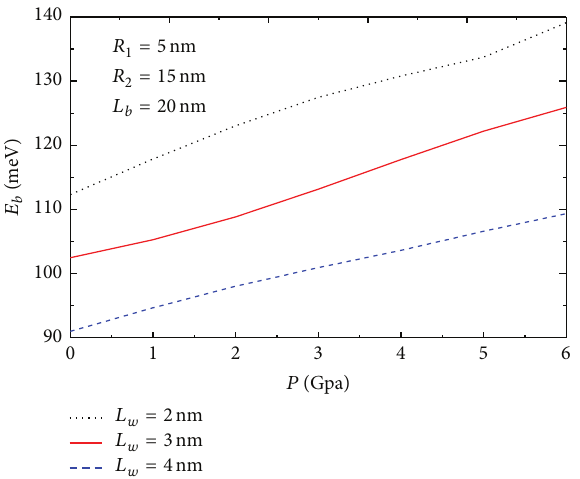
Figure 5: The ground-state donor binding energy in cylindrical wurtzite GaN/Al 𝑥 Ga 1−𝑥 N strained QR as a function of the hydro- static pressure ( 𝑃 ) for 𝑅 1 = 5 nm, 𝑅 2 = 15 nm, 𝐿 𝑏 = 20 nm, and several values of the QR height 𝐿 𝑤 .